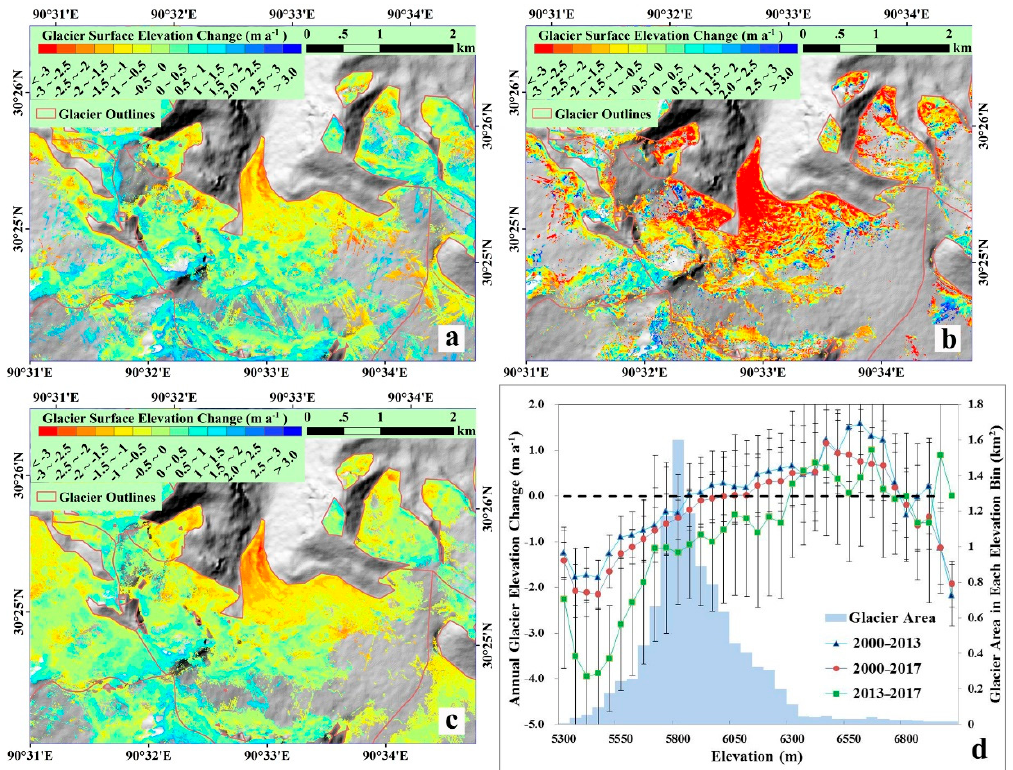
Figure 9. Annual elevation changes of unnamed glacier (GLIMs ID: G090550E30416N, the purple rectangle region in Figure 8). ( a ): 2000–2013; ( b ): 2013–2017; ( c ): 2000–2017; ( d ): annual glacier elevation changes versus elevation.